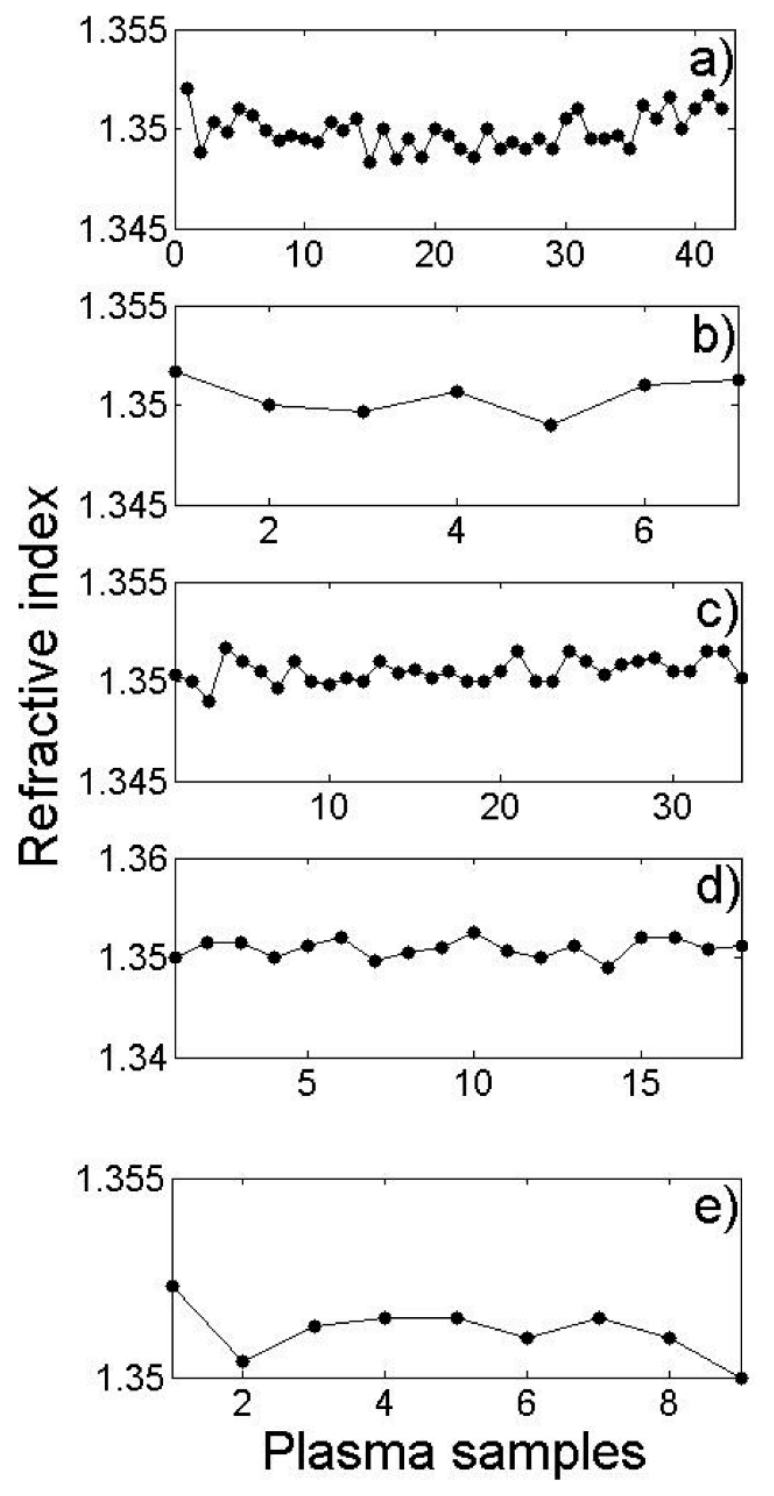
Figure 2. Graph of the plasma samples’ refractive indices measured with the Abbe refractometer: